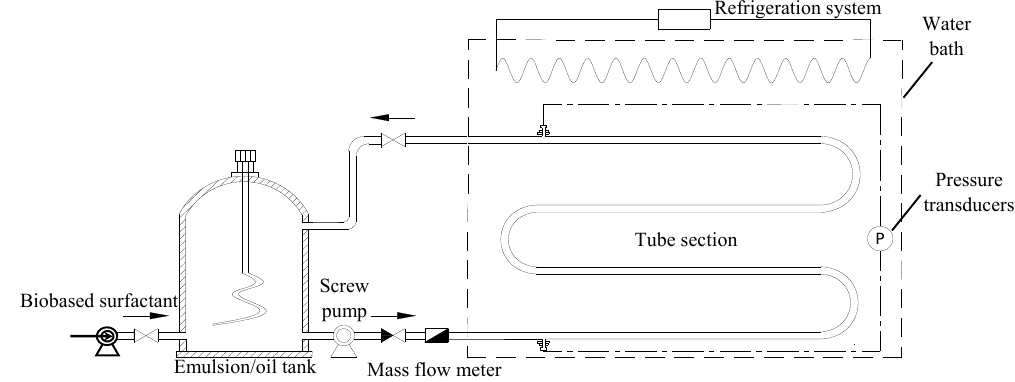
Figure 13. Schematic illustration of the flow loop device.